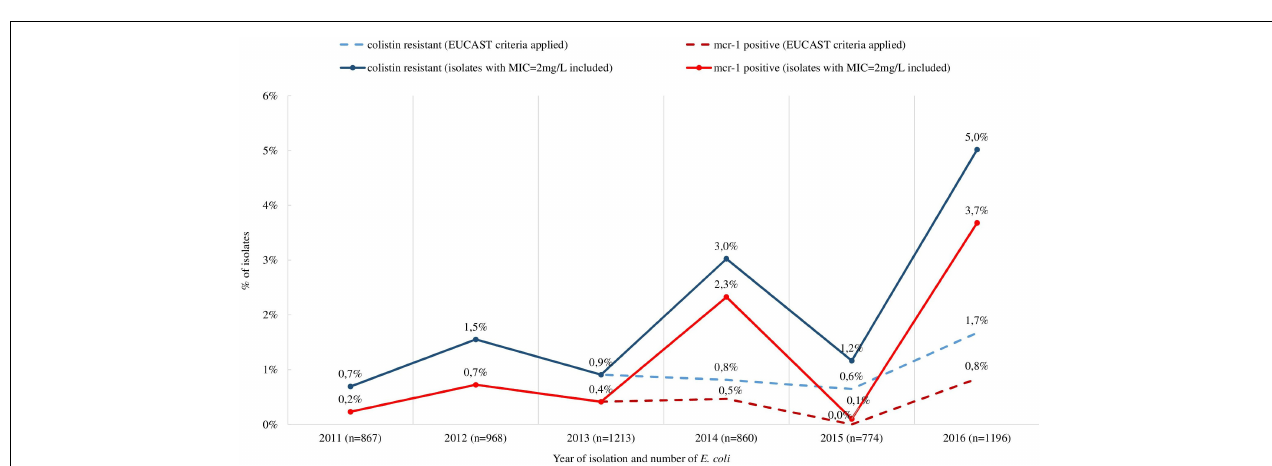
FIGURE 2 | Occurrence of isolates meeting the selection criteria (MIC > 2 mg/L for isolates in 2011–2013 and MIC ≥ 2 mg/L for isolates in 2014–2016) and mcr-1 positive commensal and ESBL/ampC producing E. coli from all tested sources (turkeys, chickens, pigs, and cattle), 2011–2016. The occurrence of colistin resistant and mcr-1 positive isolates when using exclusively EUCAST ECOFF was included (dashed